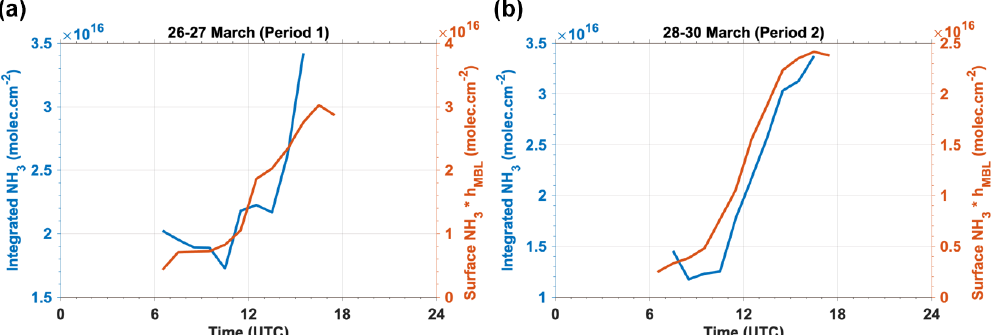
Figure 10. Diurnal evolution patterns of total column integrated ammonia concentrations retrieved by OASIS (blue lines) and surface con- centrations measured in situ at SIRTA multiplied by the mixing boundary layer derived from lidar measurements (red lines) averaged over the periods (a) 26–27 March 2012 (P1) and (b) 28–30 March 2012 (P2). This last amount provides an estimate of the vertically integrated am- monia abundance over the atmospheric mixing boundary layer heights (those shown in Fig. 9c and d) in the case of a vertically homogeneous distribution of this